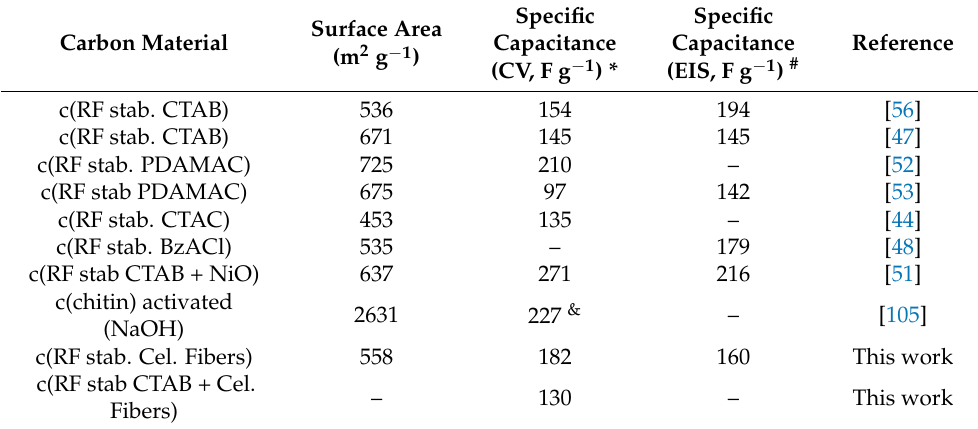
Table 2. Comparison of surface areas and specific capacitance of mesoporous carbon